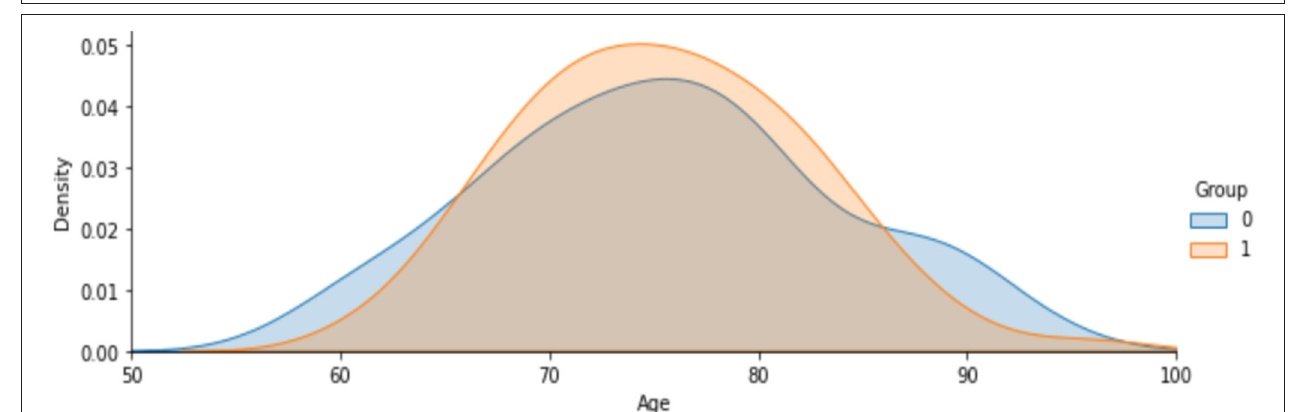
FIGURE 6 | Analysis on years of education.